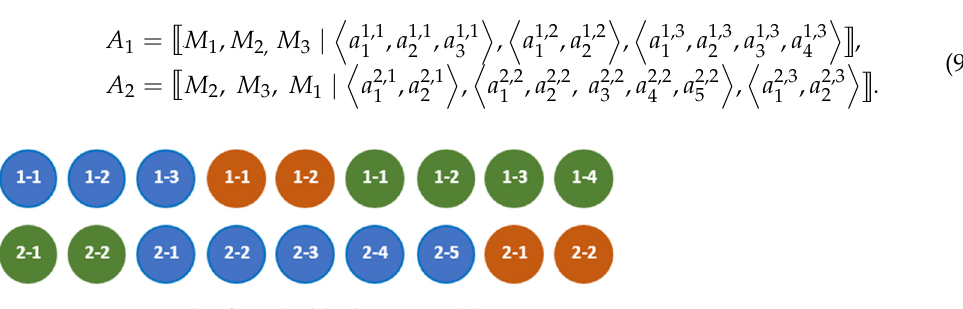
Figure 4. An example of two hiddenly compatible aggregates.